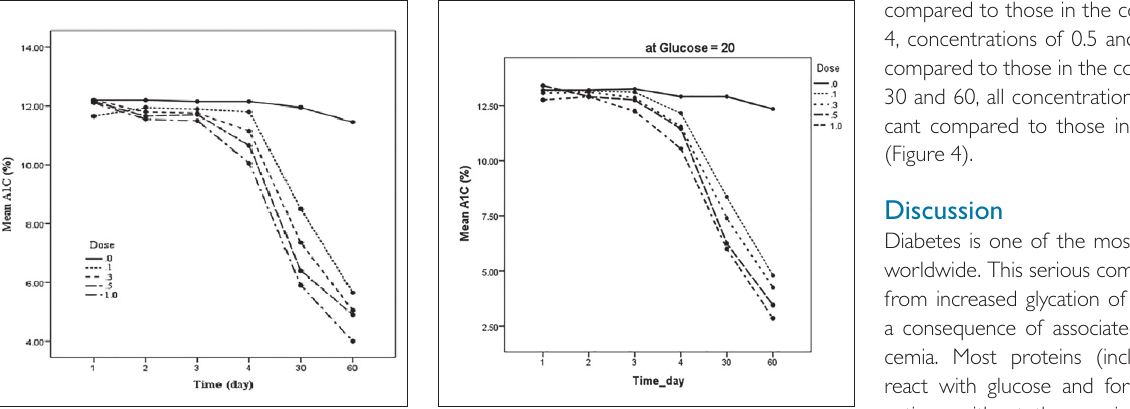
Figure 3. HbA1c incubated with 20 mM glucose and different doses of Citrullus colocynthis extract (0, 0.1, 0.3, 0.5, and 1 g/dL) in days 1, 2, 3, 4, 30, and 60 Dose 0 or positive control: HbA1c incubated with 20 mM glucose in days 1, 2, 3, 4, 30, and 60